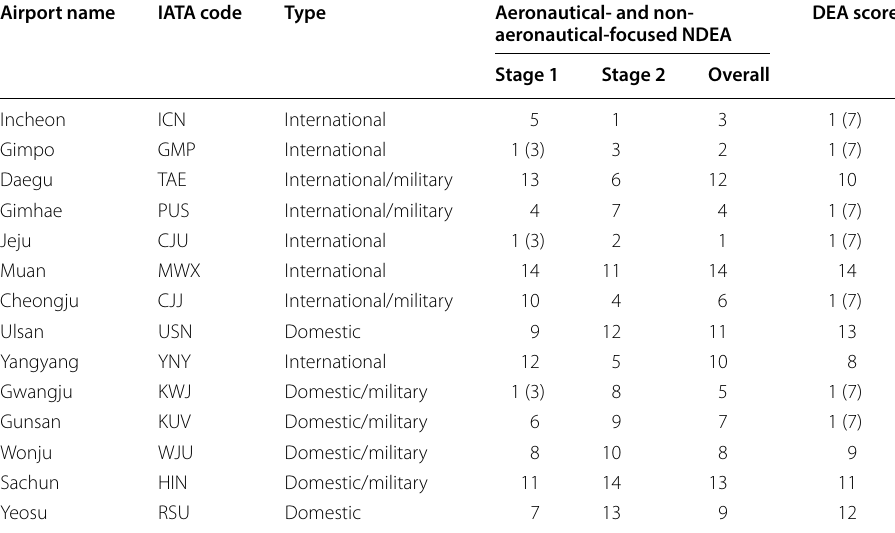
Table 4 Airport ranking based on average airport aeronautical and non-aeronautical efficiency scores